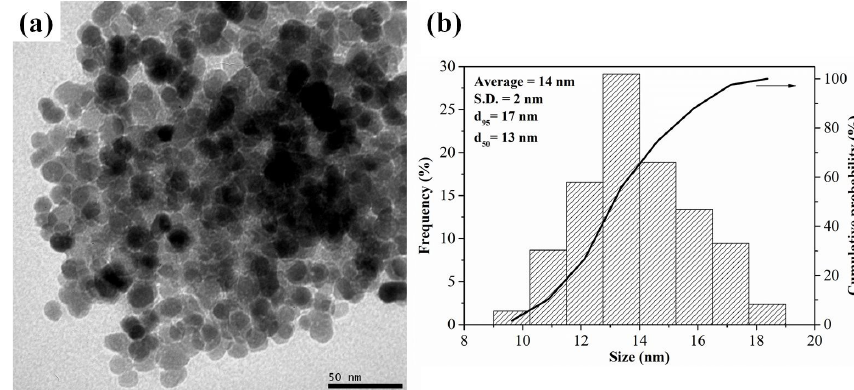
Figure 7. (a) Analysis by TEM and (b) particles distribution for ZnO